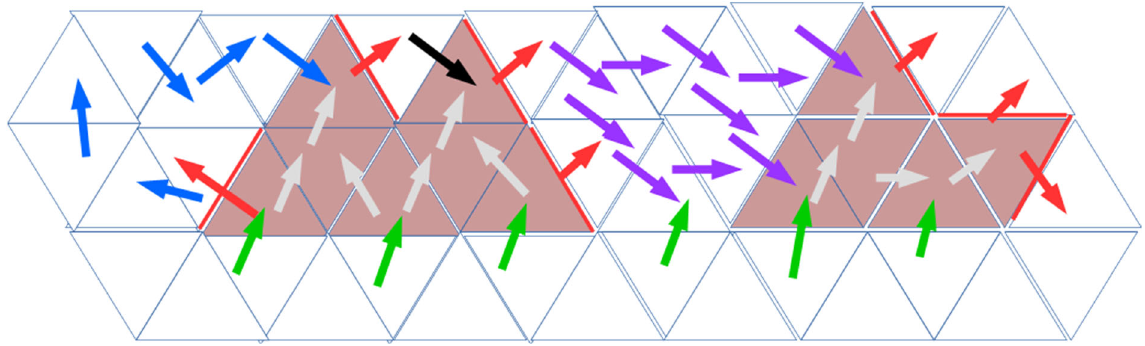
Figure 2. Possible flow cases through source elements. The source elements are filled in brown–red. Green arrows indicate the inflow of clean (uncontaminated) water, red arrows indicate the outflow of contaminated water from the source. Hereinafter, three possible types of backflow are indicated here: (1) due to “source jagging” (black arrow), not actually the case in this work if the geometry is defined appropriately, (2) due to the division of the storage space into more discontinuous parts (purple arrows), and (3) due to the actual backflow caused by curved groundwater flow lines (blue arrows).